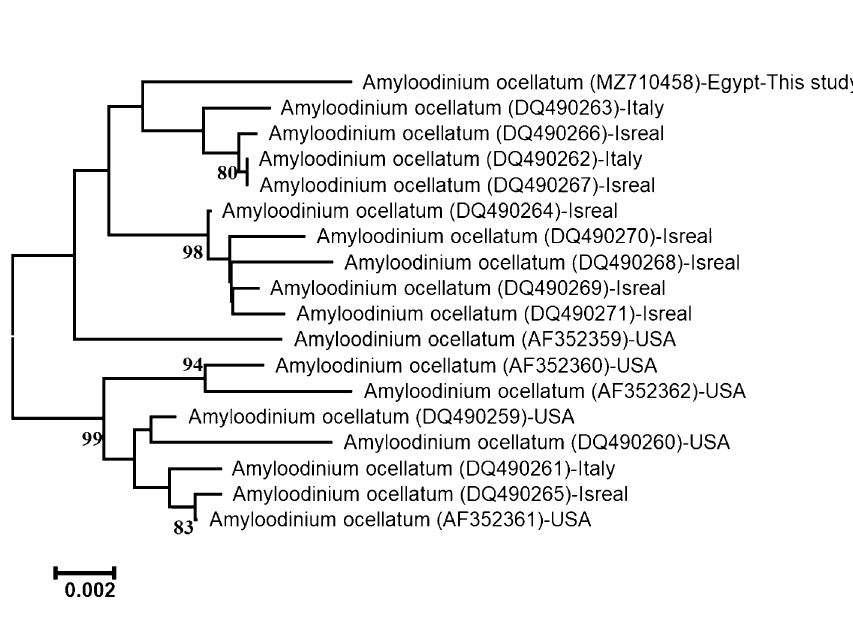
Figure 2. The neighbor-joining phylogenetic tree showed the comparative analysis of ITS rDNA region sequence of A. ocellatum infecting L. Carinata